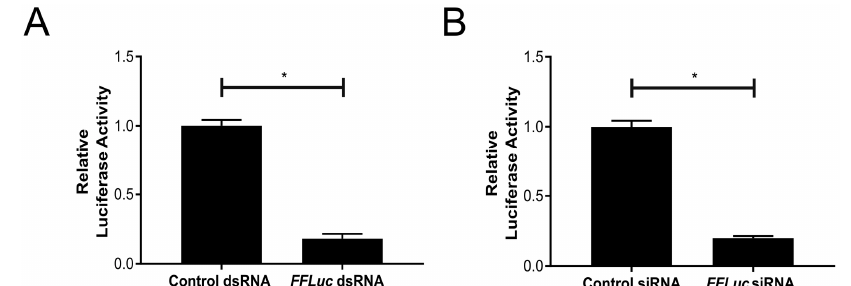
Figure 3. dsRNA or siRNA mediated gene silencing in TRA-171 cells. The cells were co-transfected with pIZ-Fluc and pAcIE1-Rluc (as an internal control) alongside either dsRNA ( A ) or siRNAs ( B ) targeting FFLuc or a control. Luciferase expression was determined by luciferase assay 24 h p.t. and relative luciferase activity ( FFLuc / RLuc ) is shown on the Y-axis. Mean values with standard error are shown for four independent experiments performed in triplicate. The analysis used the average of each triplicate per experiment. * indicates significance, p < 0.05 by Student t -test.